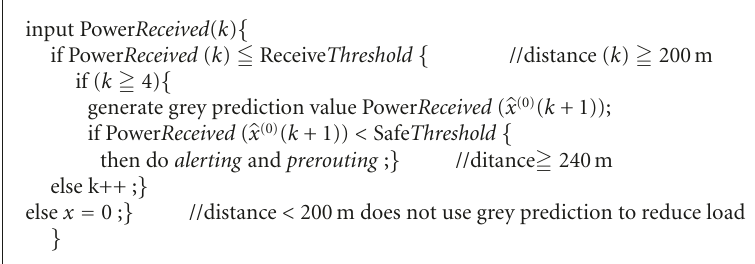
Algorithm 1: Procedure of GTTRR algorithm.